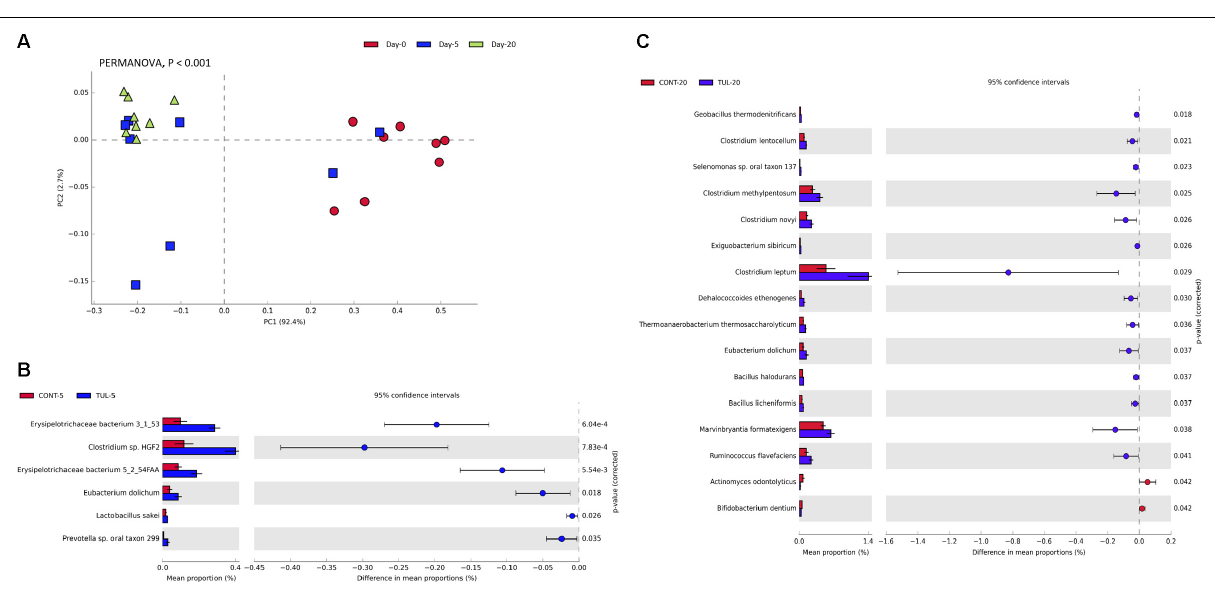
FIGURE 2 | (A) Principal component analysis (PCA) for the microbial composition at the species level across all samples at different sampling days (0, 5, and 20). The percent variation explained by each component is indicated on the axes. Significance between groups was analyzed using PERMANOVA with 9999 permutations and Bonferroni corrected P- values. (B) Bacterial species that showed significant difference when compared the control (CONT) and tulathromycin (TUL) piglets at days 5. (C) Bacterial species that showed significant difference when compared CONT and TUL-treated piglets at days